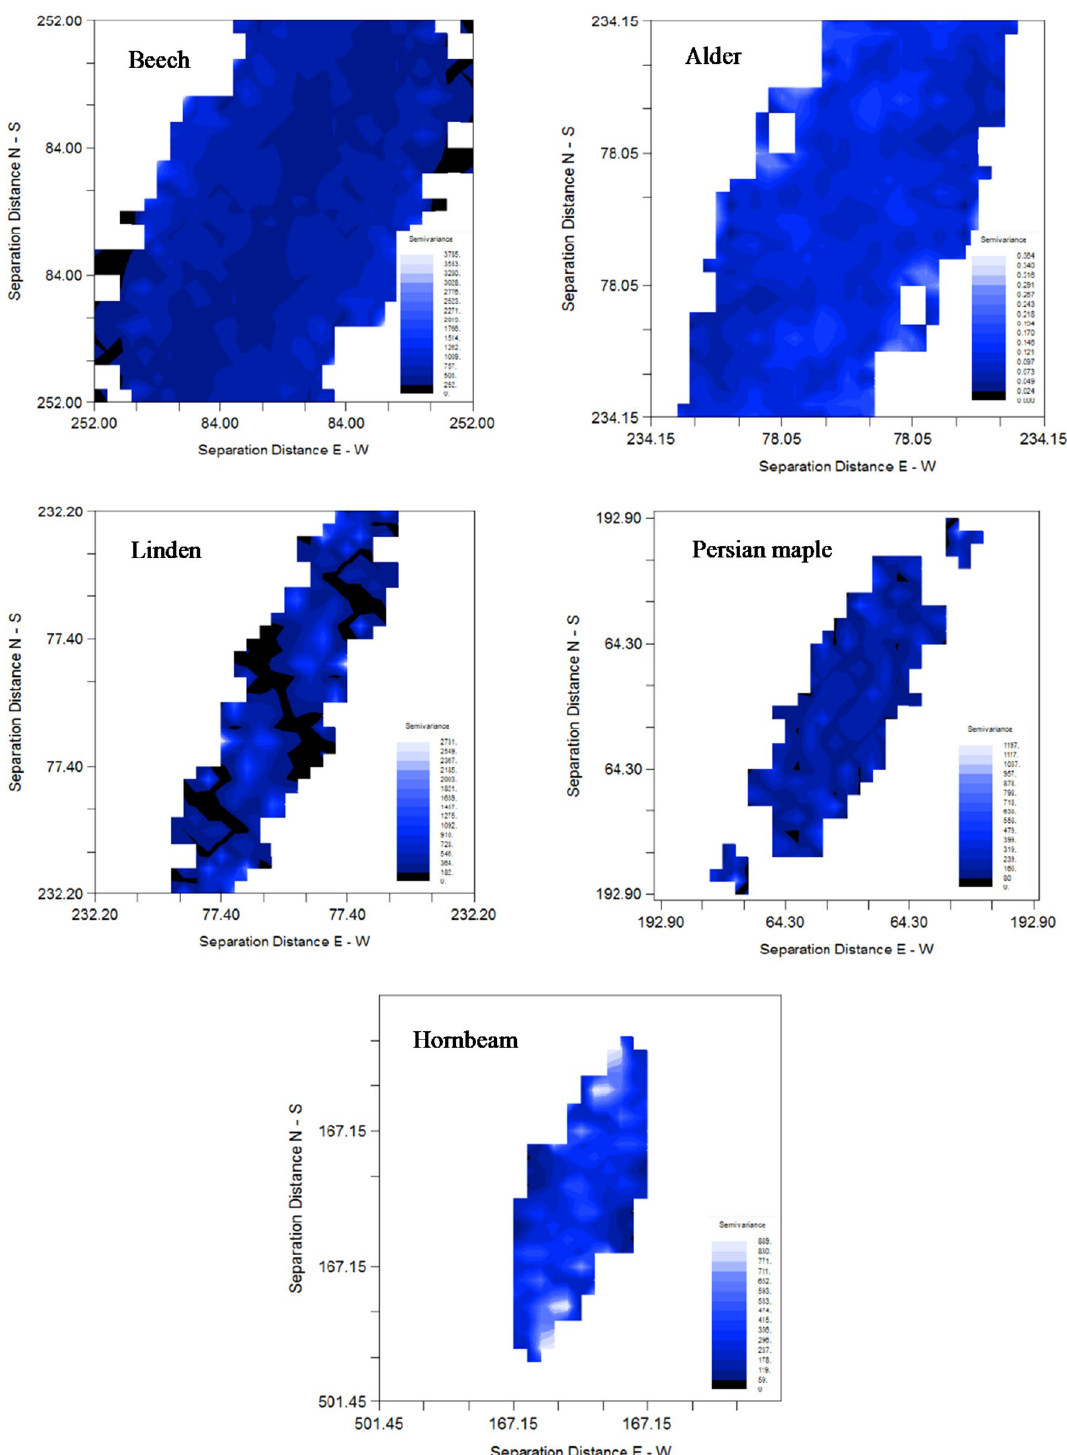
Figure 6. Surface variogram of anisotropy for beech ( Fagus orientalis ), alder ( Alnus subcordata ), linden ( Tilia platyphyllos ), Persian maple ( Acer velutinum ) and hornbeam ( Carpinus betulus ). A surface variogram is used to detect the presence and direction of anisotropy in the data. If anisotropy is present, the variogram calculated for that species will be different when measured in different